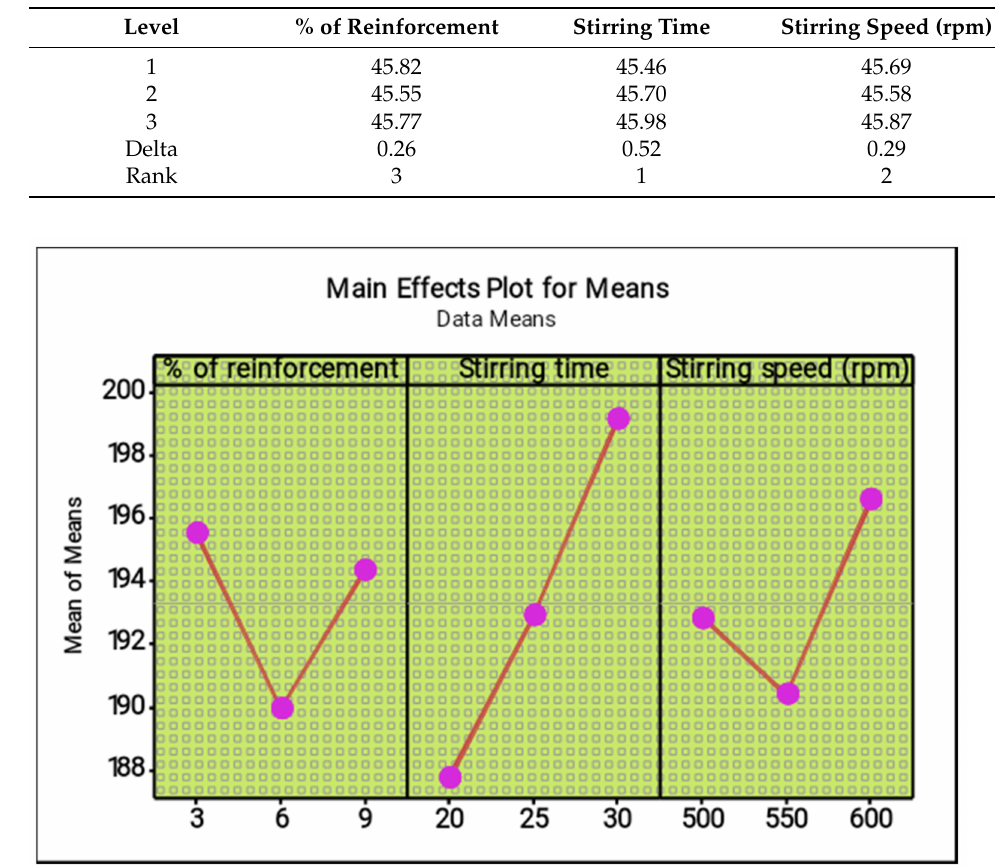
Figure 7. Main effect plot for means (ultimate tensile